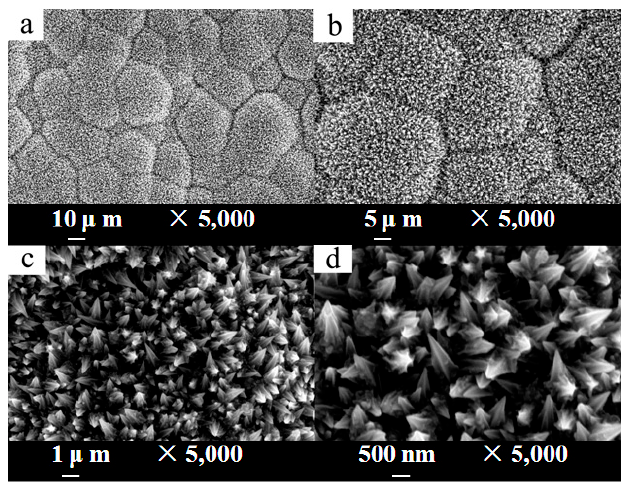
Figure 3. Scanning electron microscopy (SEM) images of the as-prepared superhydrophobic surface with different magnifications. ( a ) 5,000 times; ( b ) 10,000 times; ( c ) 50,000 times; ( d ) 100,000 times.